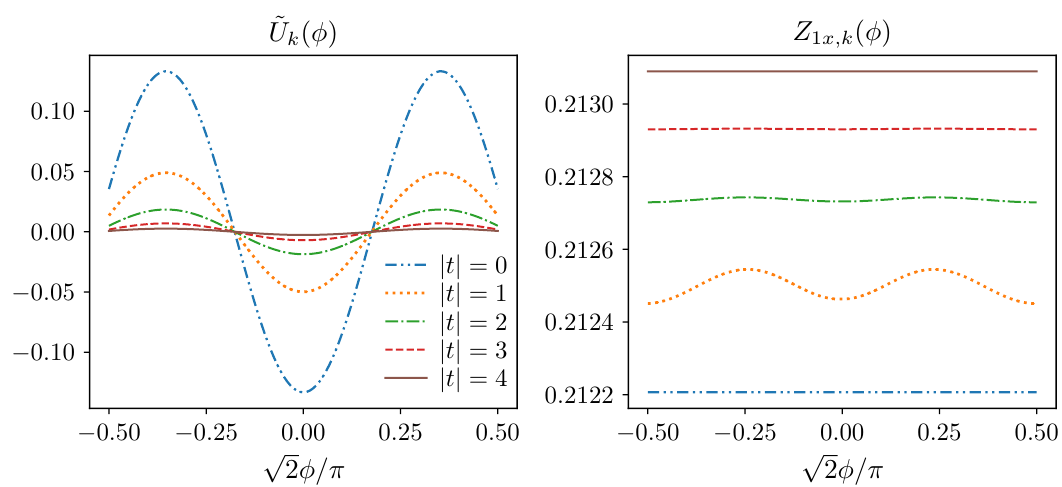
( φ ) = U ( φ ) / Z ( φ ) in the Luttinger-liquid phase for var- k 2 and Z Figure 1: ˜ U k k 1, k 1 x , k ( φ ) is related to Z ( φ ) by Eq. (19). In Figs. 1 and 2, ious values of k ≤ Λ . Z 1 τ , k 1 x , k t = ln ( k / Λ ) denotes the (negative) RG time. ( Λ = 1, u / Λ 2 = 0.01 and K = 1.5.) Density-density correlation